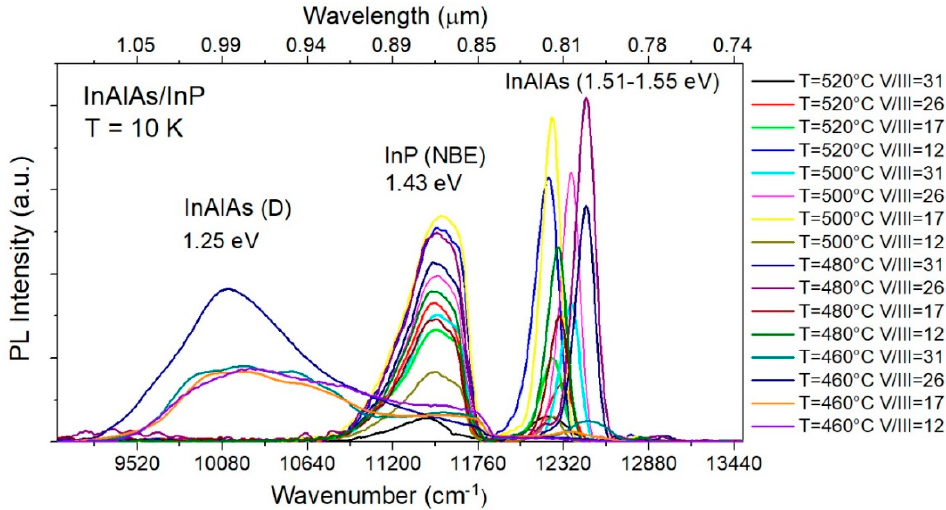
Figure 9. Low temperature PL spectra of In 0.52 Al 0.48 As/InP samples grown at different temperatures and V / III flux ratios. PL was excited by 650 nm (1.91 eV) laser diode.